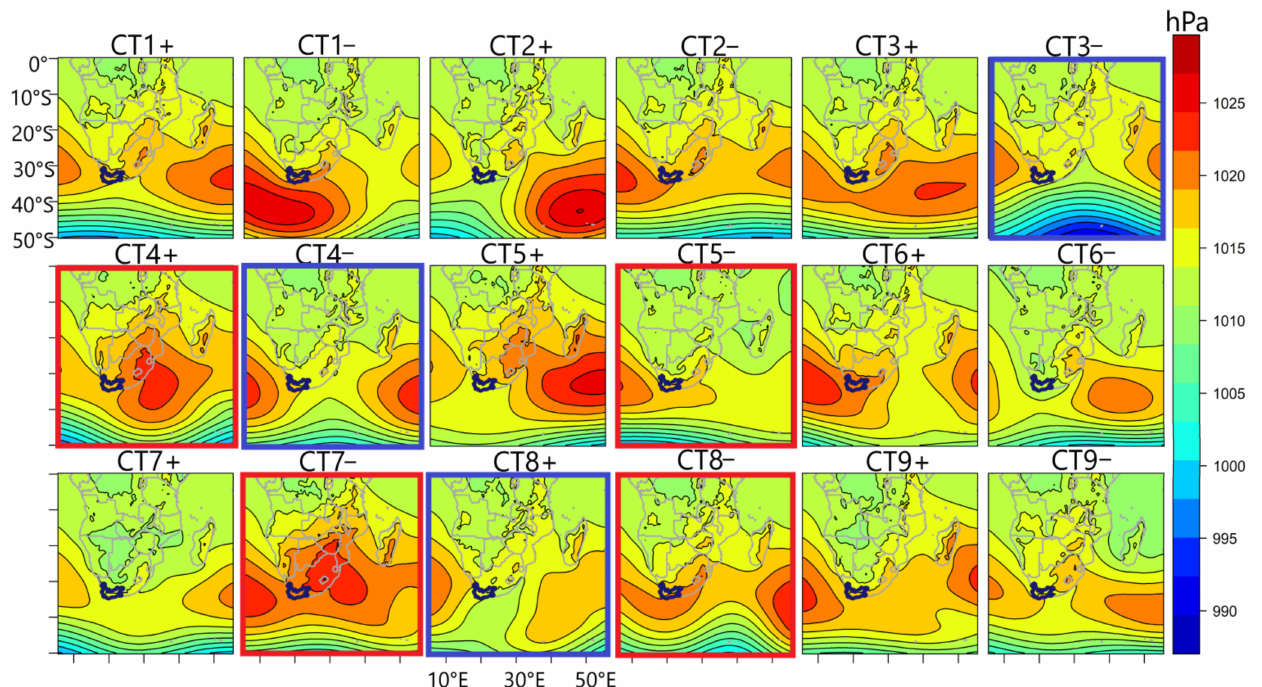
Figure 3. Circulation types in the study region. The CTs are presented by the mean SLP field of the days clustered in a given class. Wet (dry) CTs in the Western Cape are marked by the blue (red) frames. The blue polygons in the maps delineate the position of the Western